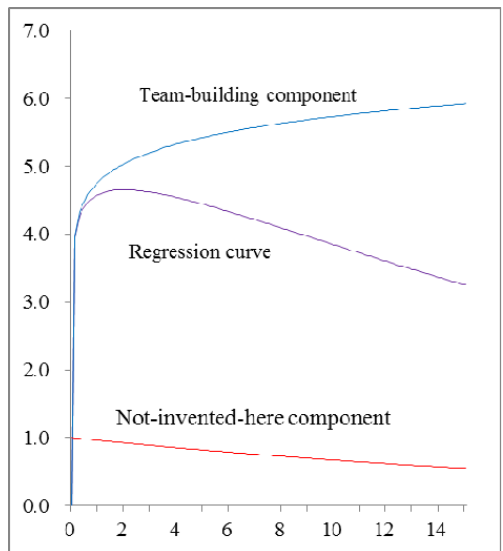
Figure 1. Regression curve, team-building component and NIH